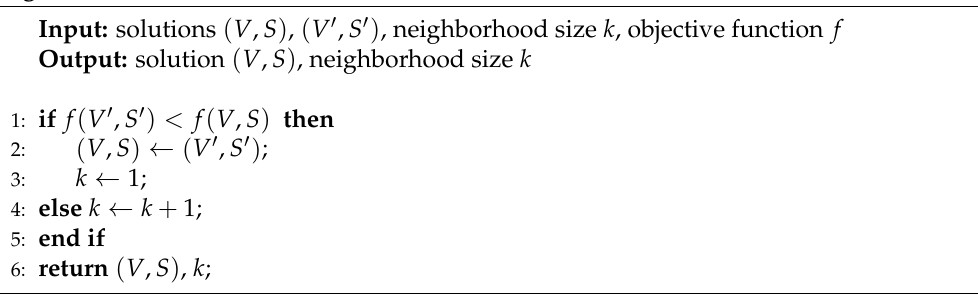
Algorithm 4 NEIGHBORHOODCHANGE .